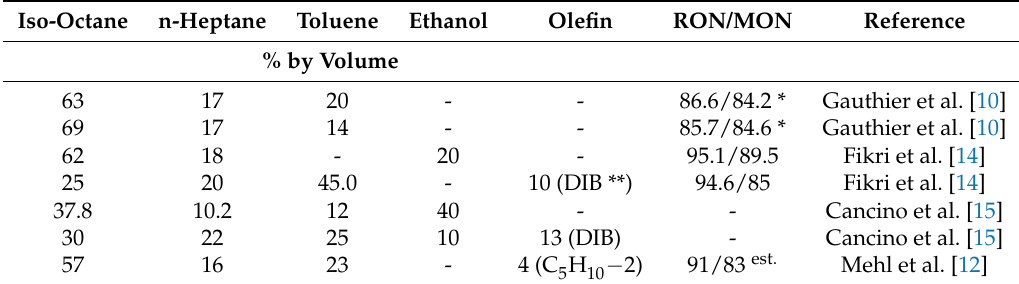
Table 1. Volumetric composition of various gasoline surrogate blends the iginition delays of which have been